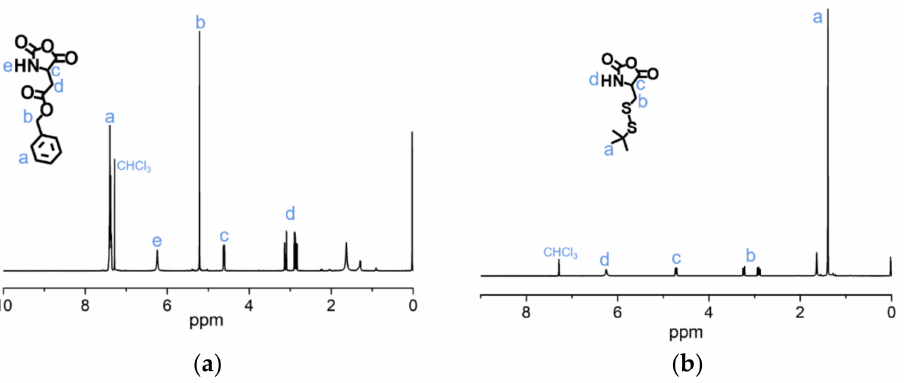
Figure 3. 1 H-NMR analyses of ( a ) BLA-NCA and ( b ) tBMLC-NCA in CDCl 3 .